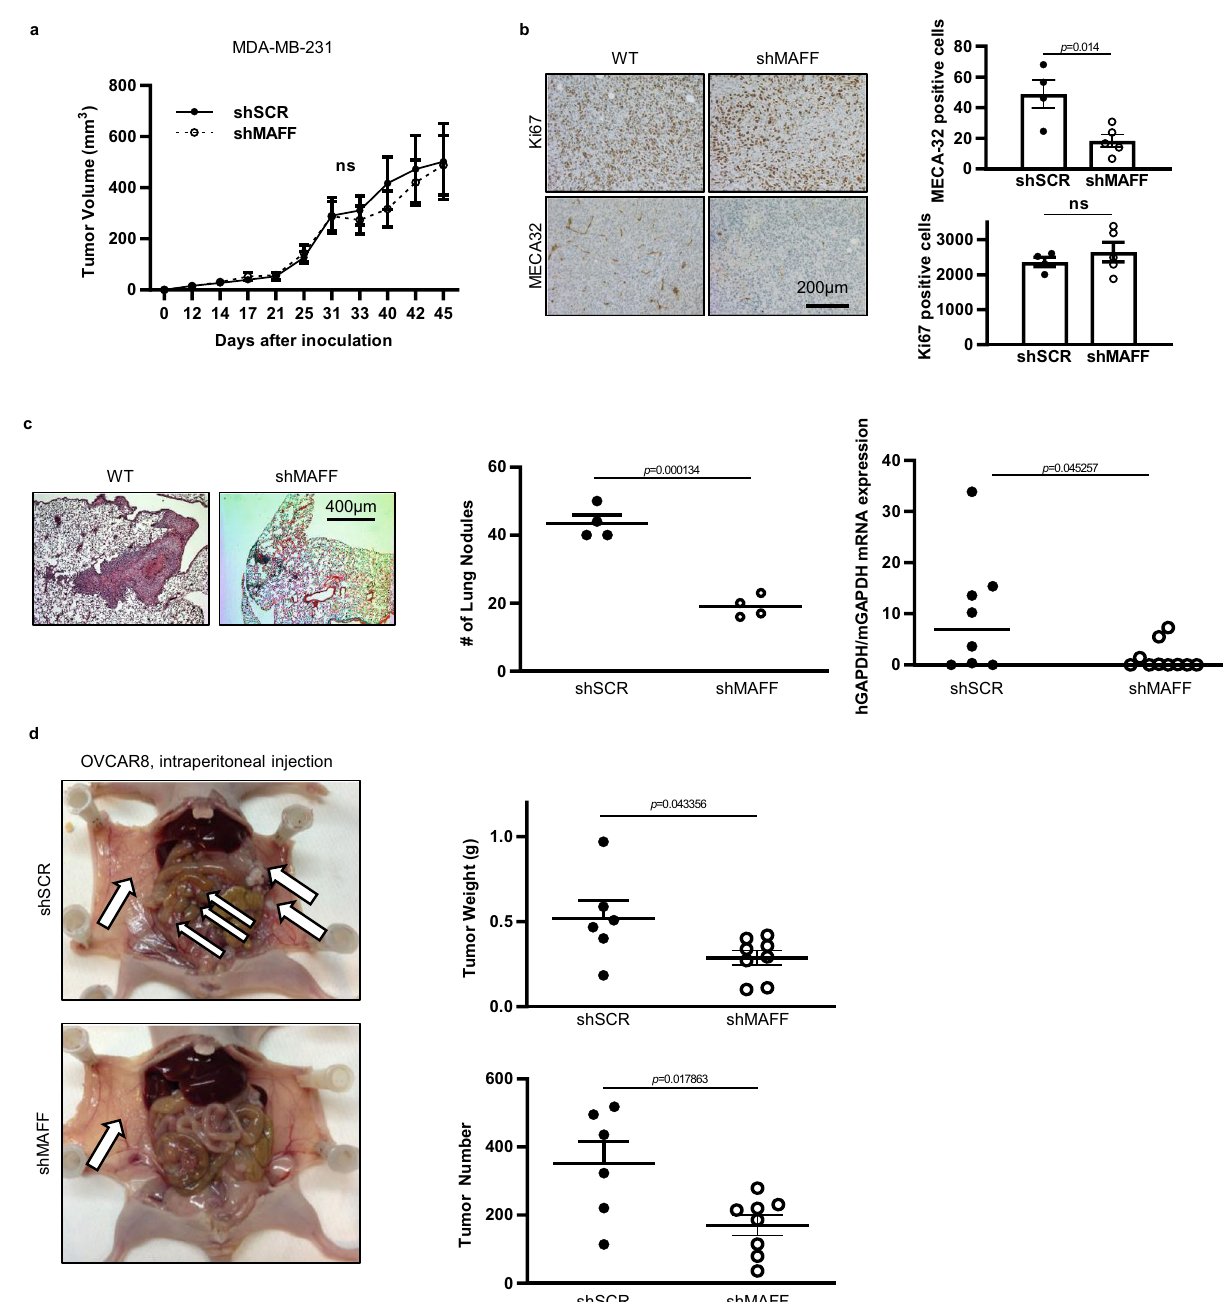
Fig. 4 MAFF regulates in vivo tumor metastasis. MDA-MB-231 cells were orthotopically injected into mammary fat pads of nude mice (10 6 cells/50 μ l/ mouse) to determine the role of MAFF in tumor growth. a MAFF inhibition did not affect tumor growth in vivo (ns: not signi fi cant). n = 9 shSCR, n = 7 shMAFF. Two-Way ANOVA. b While cell proliferation (Ki67 positive staining) was not changed, microvessel density (MECA32 positive staining) signi fi cantly decreased when MAFF was inhibited ( n = 4 shSCR, n = 5 shMAFF). Unpaired t -test. c Lung colonization of tumor cells was evaluated either by H&E staining ( n = 4) or qPCR to measure human GAPDH expression ( n = 9 shSCR, n = 7 shMAFF). Unlike primary tumor growth, MAFF knockdown reduced lung metastasis. Unpaired t -test. d Intraperitoneal injection of OVCAR8 cells also showed that inhibition of MAFF expression was signi fi cantly correlated with reduced tumor metastasis. Arrow indicates tumor nodules formed in intraperitoneal cavity. n = 6 shSCR, n = 8 shMAFF. Unpaired t -test. Graphs represent the mean per group and error bars represent the SEM. ns: not signi fi